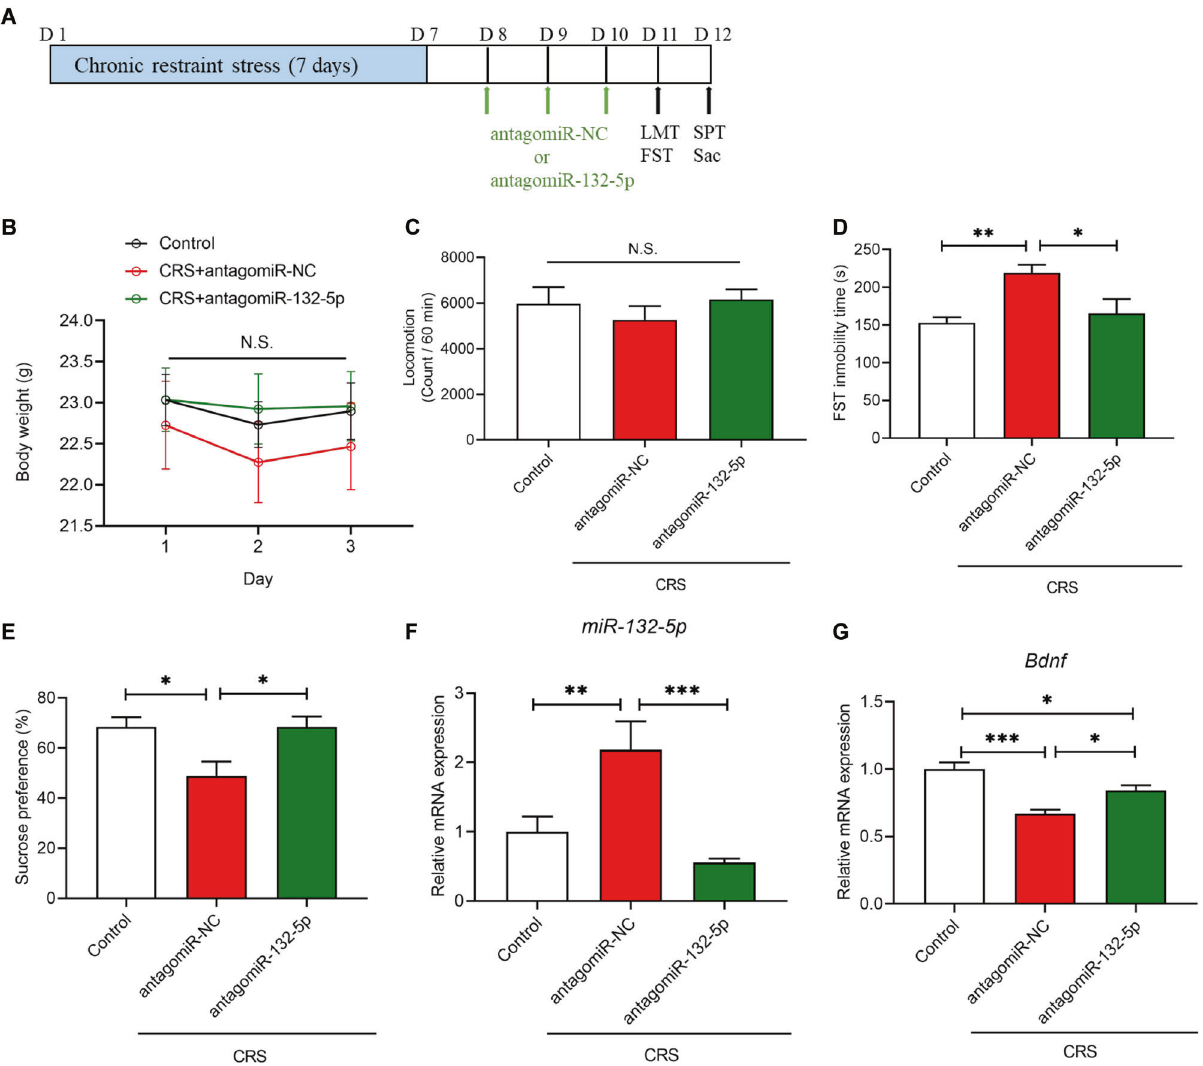
Fig. 5 Effects of miR-132-5p knockdown on depression-like phenotype in CRS-induced mice. A Treatment schedule. Chronic restraint stress (CRS) was performed 7 days (day 1 – day 7). Subsequently, antagomiR-132-5p (200 nmol, 2 μ l/day) or antagomiR-NC (control: 2 μ l/day) was administered i.c.v. to mice 3 days after CRS (day 8 – day 10). Locomotion test, forced swimming test (FST) and sucrose preference test (SPT) were performed after the injection of antagomiR-NC or antagomiR-132-5p (day 11 and day 12). The prefrontal cortex (PFC) was collected after SPT. B Body weight change (two-way repeated measures ANOVA: F 4,52 = 1,125, P = 0.300). C Locomotion test (one-way ANOVA: F 2,26 = 0.587, P = 0.563). D FST (one-way ANOVA: F 2,26 = 6.709, P = 0.005). E SPT (one-way ANOVA: F 2,26 = 5.581, P = 0.010). F Expression of miR-132-5p in the PFC (one-way ANOVA: F 2,26 = 10.470, P = 0.0005). G Bdnf mRNA in the PFC (one-way ANOVA: F 2,26 = 15.740, P < 0.0001). The data represent mean ± SEM ( n = 9 or 10). * P < 0.05, ** P < 0.01, *** P < 0.001. N.S., not signi fi